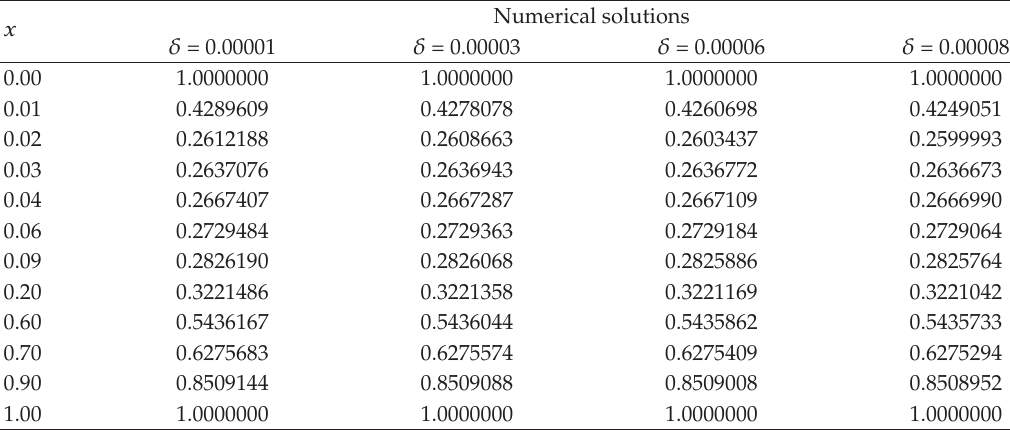
Table 6: Numerical results of Example 4.2 for ε (cid:8) 0 . 0001, N (cid:8) 100, and di ff erent values of δ